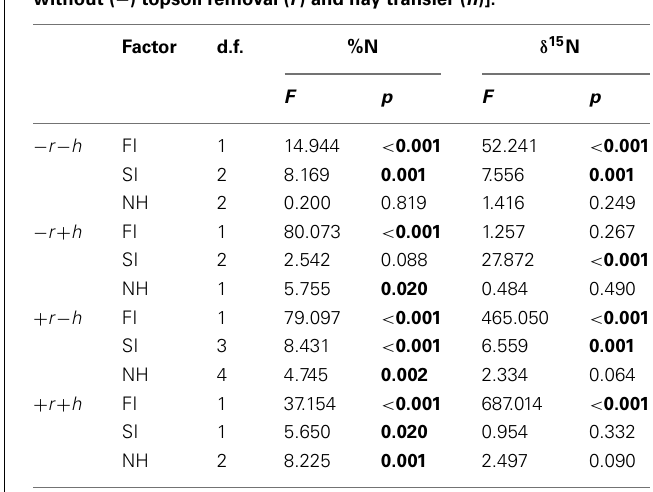
Table 4 |ANOVA (sequentialType I Sum of Squares) results for effects of functional identity (FI), species identity (SI), and effect of neighborhood (NH) on N concentration and δ 15 N in plant leaves in all species , analyzed separately by restoration treatment [with ( + ) or without ( − ) topsoil removal ( r ) and hay transfer ( h